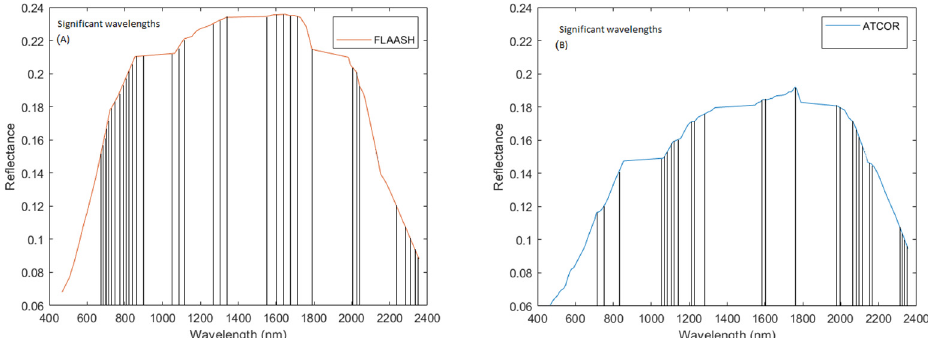
Figure 7. Spectral signature of the same bare soil pixel corrected by ( A ) FLAASH for an AOD level of 80 and the significant wavelengths for the associated PLSR model (highlighted by gray vertical lines); ( B ) ATCOR for an WV of 2 cm and the significant wavelengths for the associated PLSR model (highlighted by gray vertical lines).